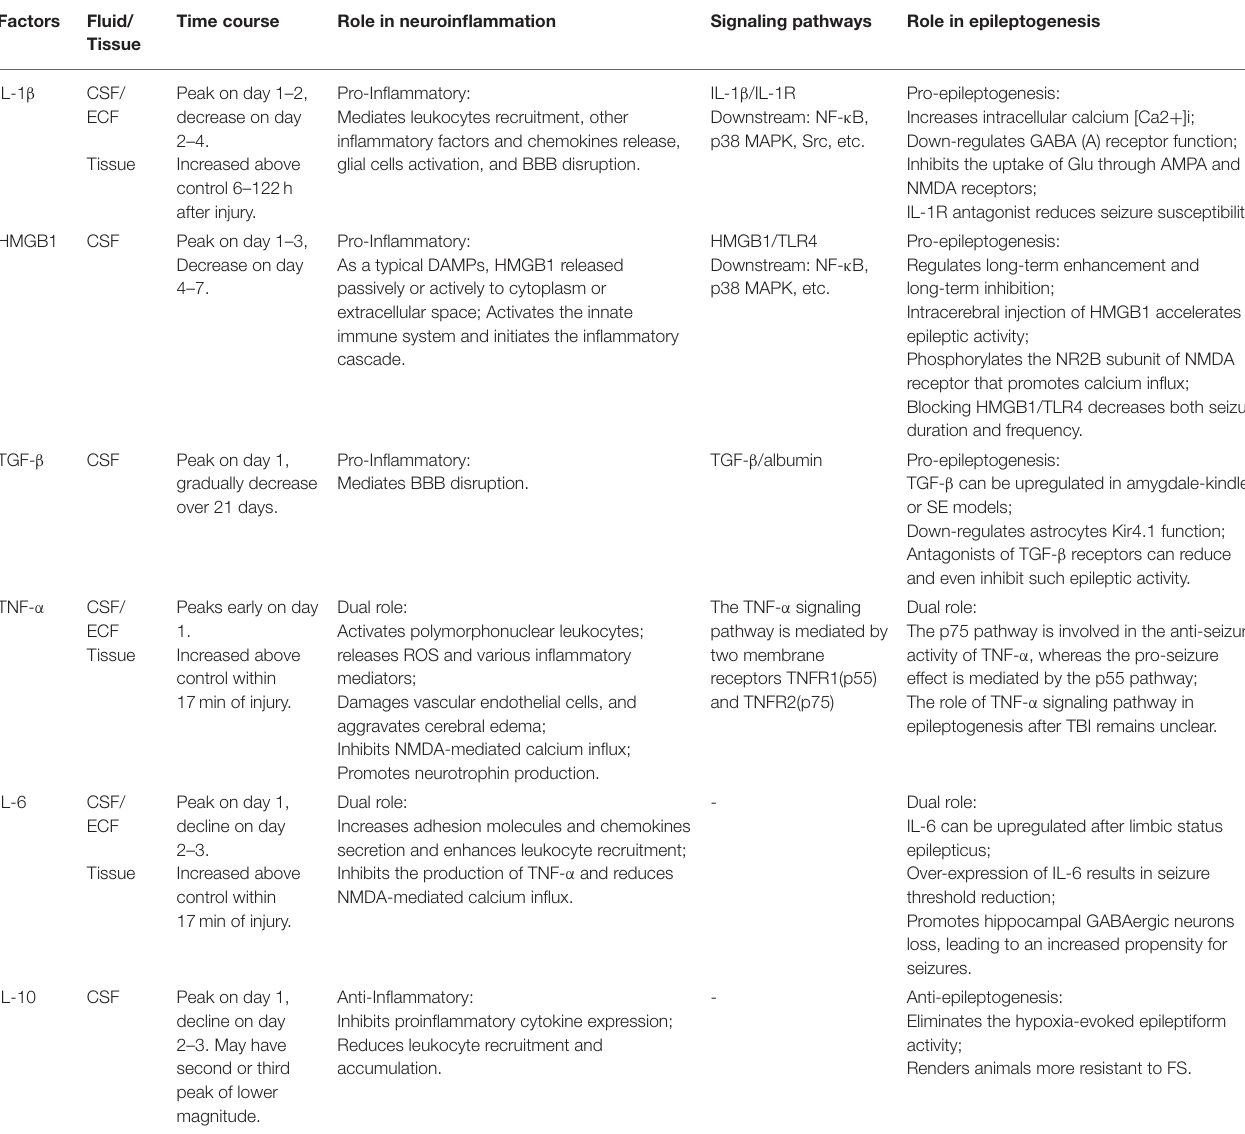
TABLE 1 | Key inflammatory cytokines involved in post-traumatic seizure/epilepsy. Factors Fluid/